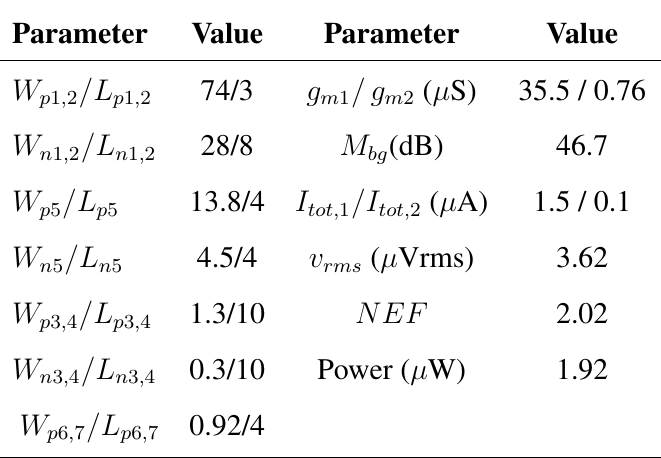
Table 3. Sizing results for the proposed